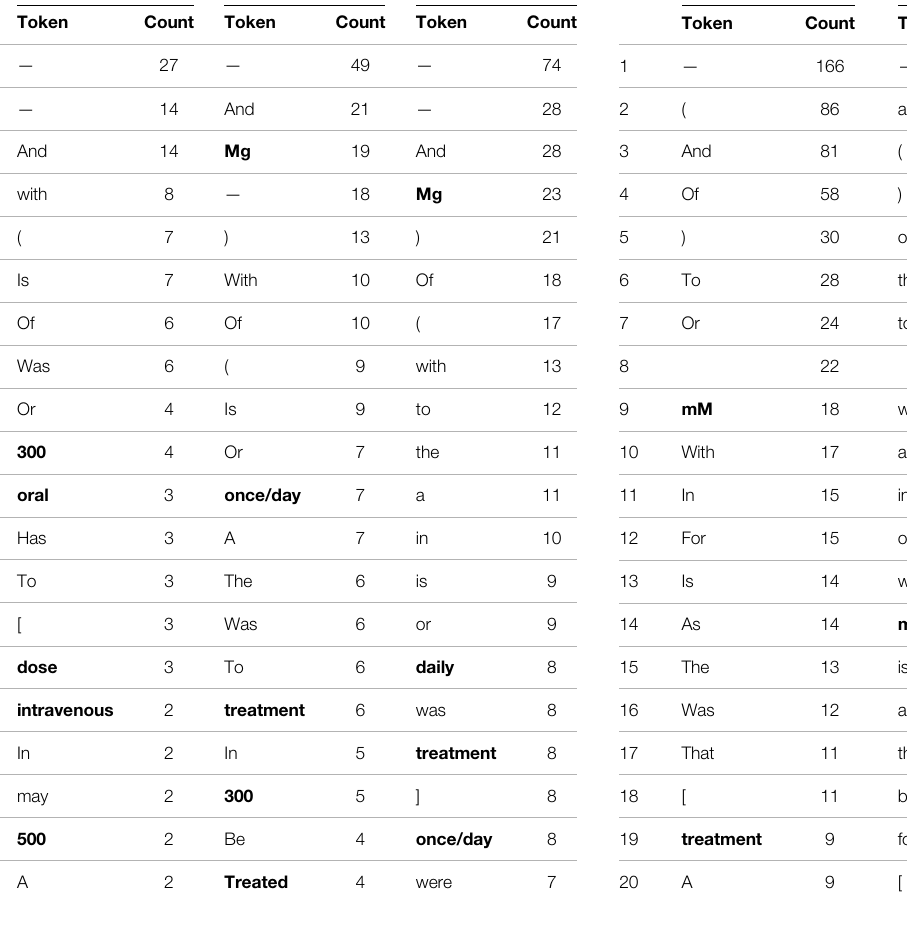
TABLE 5 | The 20 most frequent tokens, including stop words and punctuation marks, within various window sizes around entities incorrectly labeled by humanreviewers. Wordsthatareneitherstop words norpunctuationwords arein boldface. Window size = 1